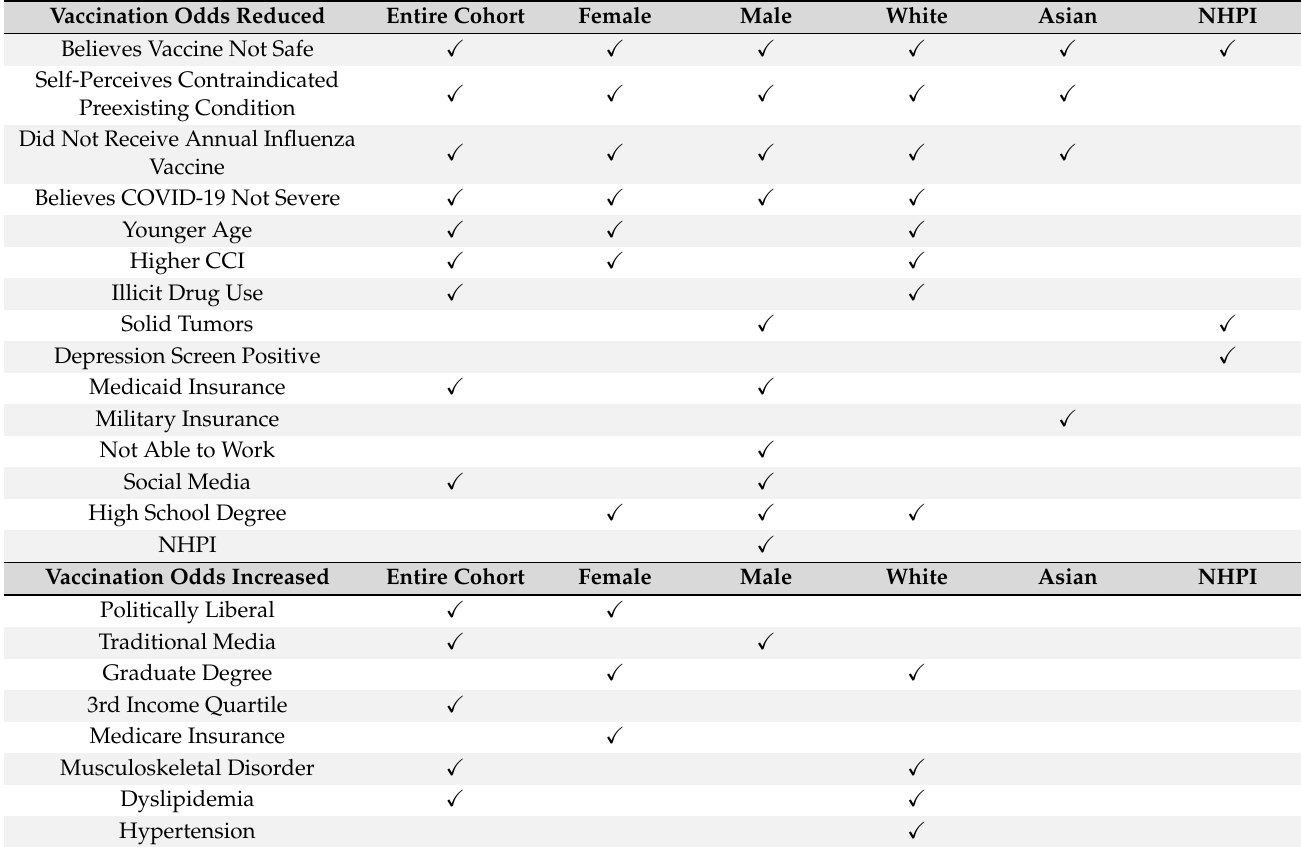
Vaccination Odds Increased